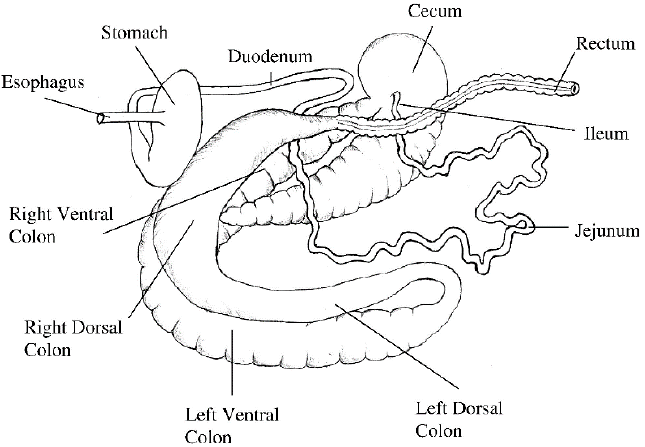
Figure 1. Isolated gastrointestinal tract of the adult horse. Image reprinted with permission from Van Weyenberg and Janssens [48]. 2022, Elsevier .